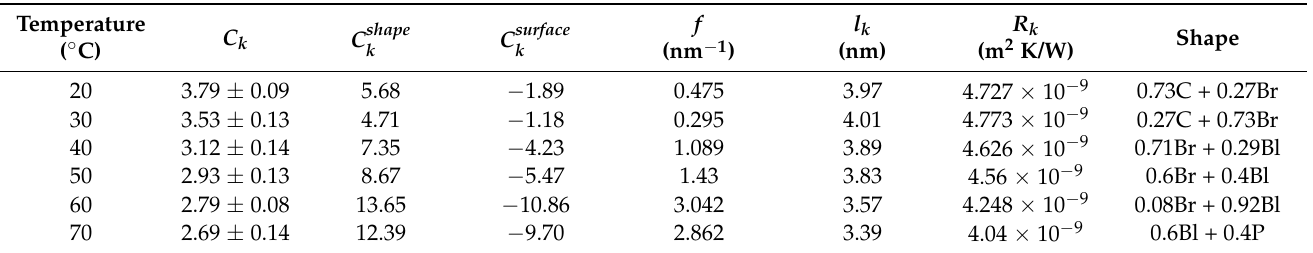
Table 1. Contribution of particle shape effect and surface resistance to the thermal conductivity of ZnO powder in 40:60